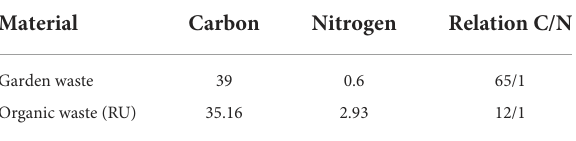
TABLE 1 Initial characterization of